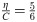
(a)—(b) With different parameters to compare the numerical simulations and the theoretical prediction of the degree distribution P(k) for the model D.(a) After time t = 1000, five groups of the parameters are ηC=56, m0 = m = 3, n = 6, q = 4; ηC=47, m0 = m = 5, n = 4, q = 1; ηC=821, m0 = m = 5, n = 4, q = 1; ηC=12, m0 = 3, n = 2, m = q = 0; ηC=313, m0 = m = 10, n = 6, q = 1;. Blue, black, red, green and fuchsine solid lines stand for the theoretical degree distribution P(k); green plus, red asterisk, black circle, fuchsine diamond and blue lower triangle stand for the numerical simulation of degree distribution P(k) of five groups respectively. (b) The numerical simulations of degree distribution P(k) with different competition abilities and the static parameters C = 2, m = 8, n = 5, q = 1.